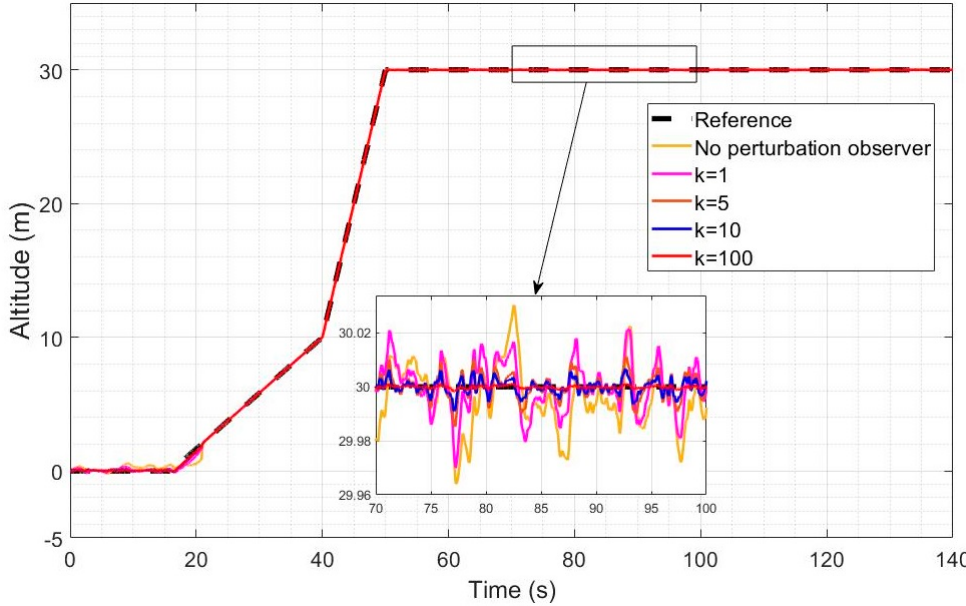
Figure 9. Axial peed reference tracking under a low wind intensity for different values of the perturbation observer gain.